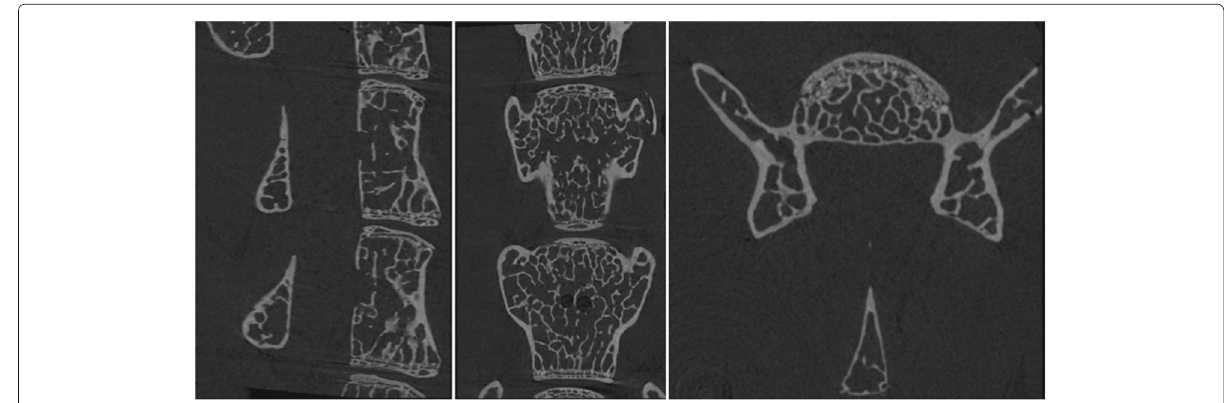
Fig. 2 The sagittal, coronal, and axial views of the input